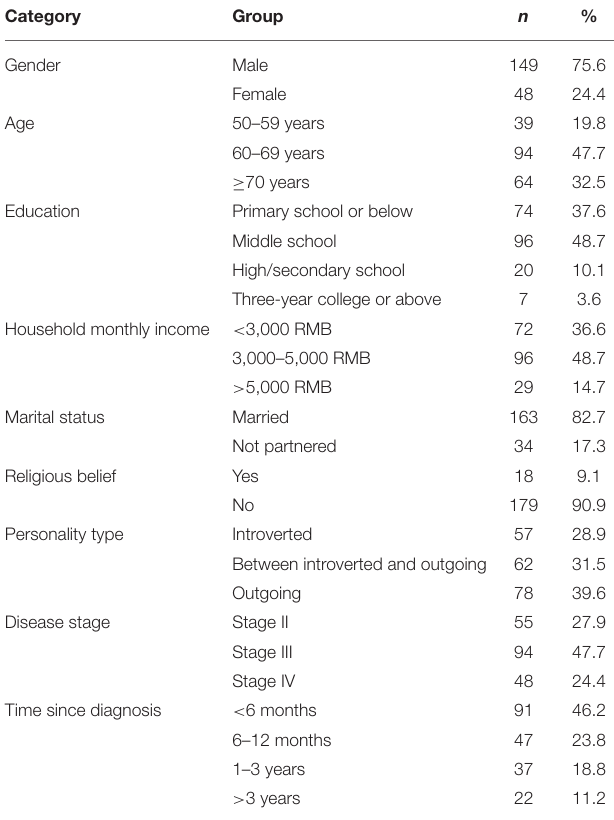
TABLE 1 | Demographic and clinical characteristics of 197 participants ( N =